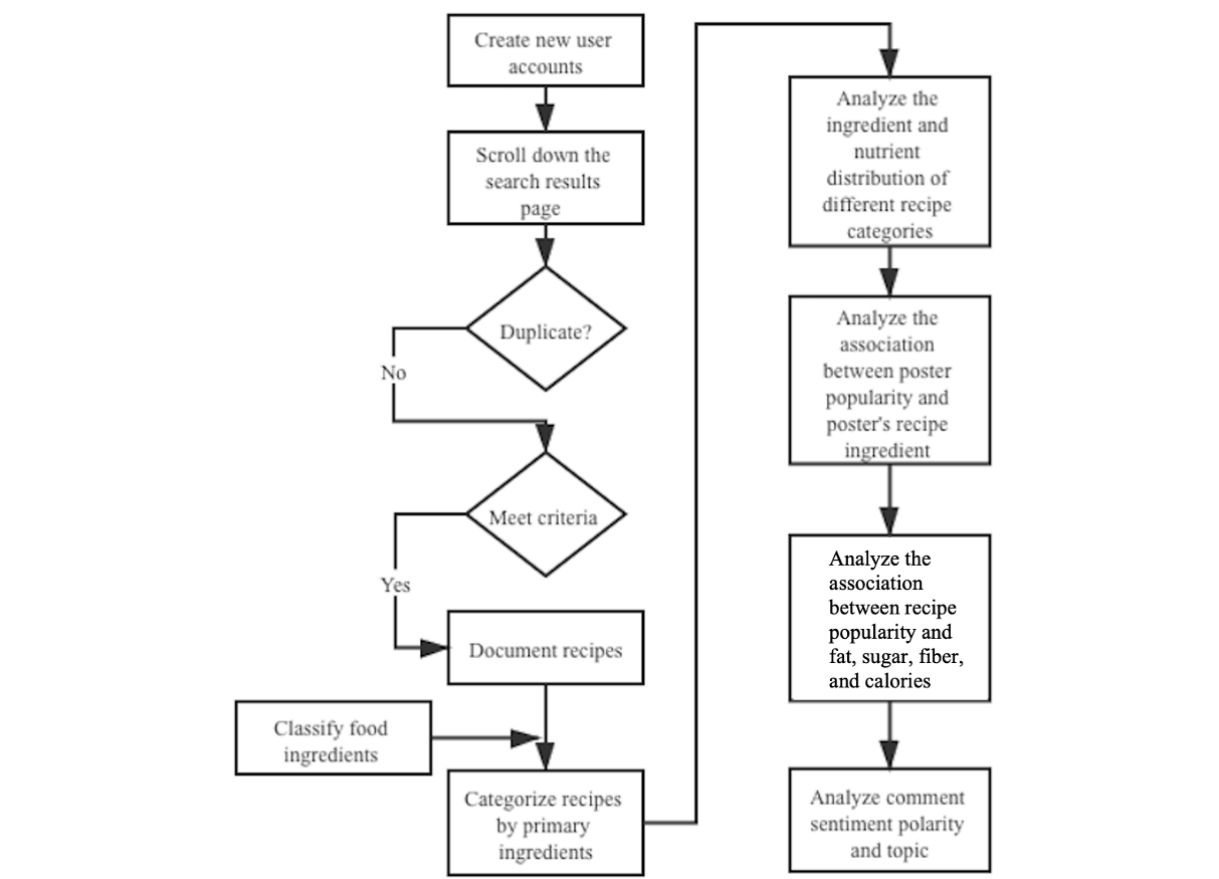
Figure 1. Process of data collection and